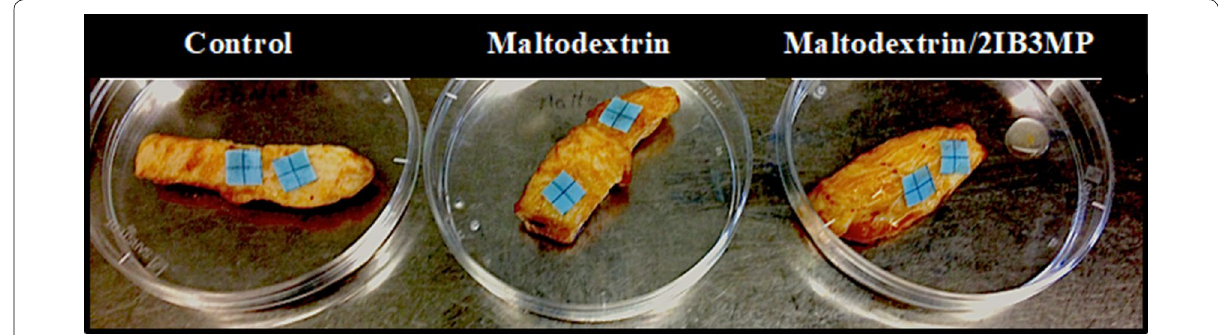
Fig. 1 New imprint method for the visualization of microbial contaminations on processed meat strips. The textile pieces were placed onto the meat pieces after they were incubated for 72 h at 4 °C and were then incubated for additional 24 h before differential staining and confocal micros-